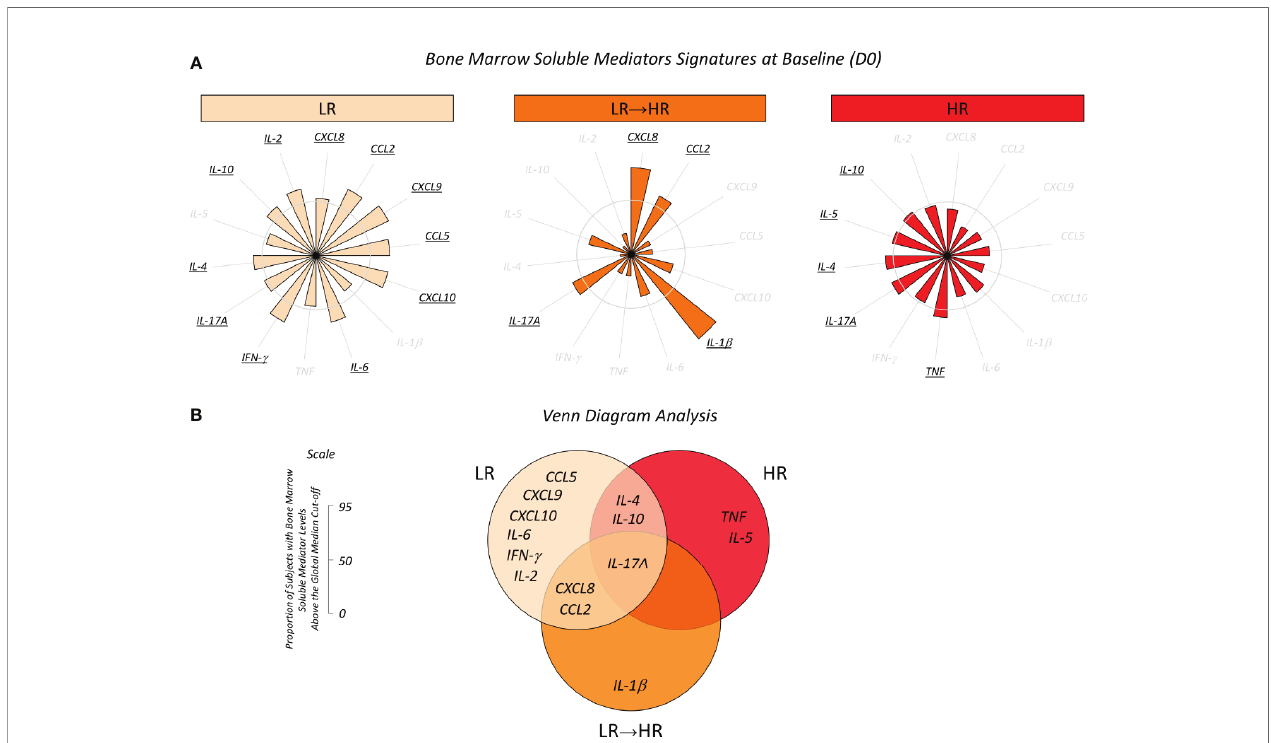
FIGURE 2 | Overall signature of bone marrow soluble mediators in B-ALL patients according to the risk group strati fi cation on D15. (A) Bone marrow soluble mediator signature at baseline (D0) in B-ALL patients categorized according to their risk group strati fi cation on D15 of induction therapy, denominated as LR ( ), and Methods section. Data, originally expressed in MFI or pg/mL (IL-1 b and IL-5) were converted into categorical data using the global median values obtained for each biomarker as the cut-off to classify each patient since they presented low or high levels of immunological mediators in the bone marrow plasma. The biomarker